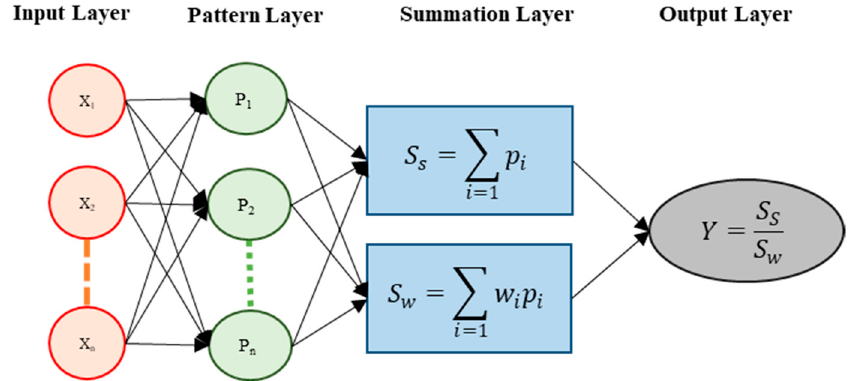
Figure 1. Schematic diagram of the proposed generalized regression neural network (GRNN) model.